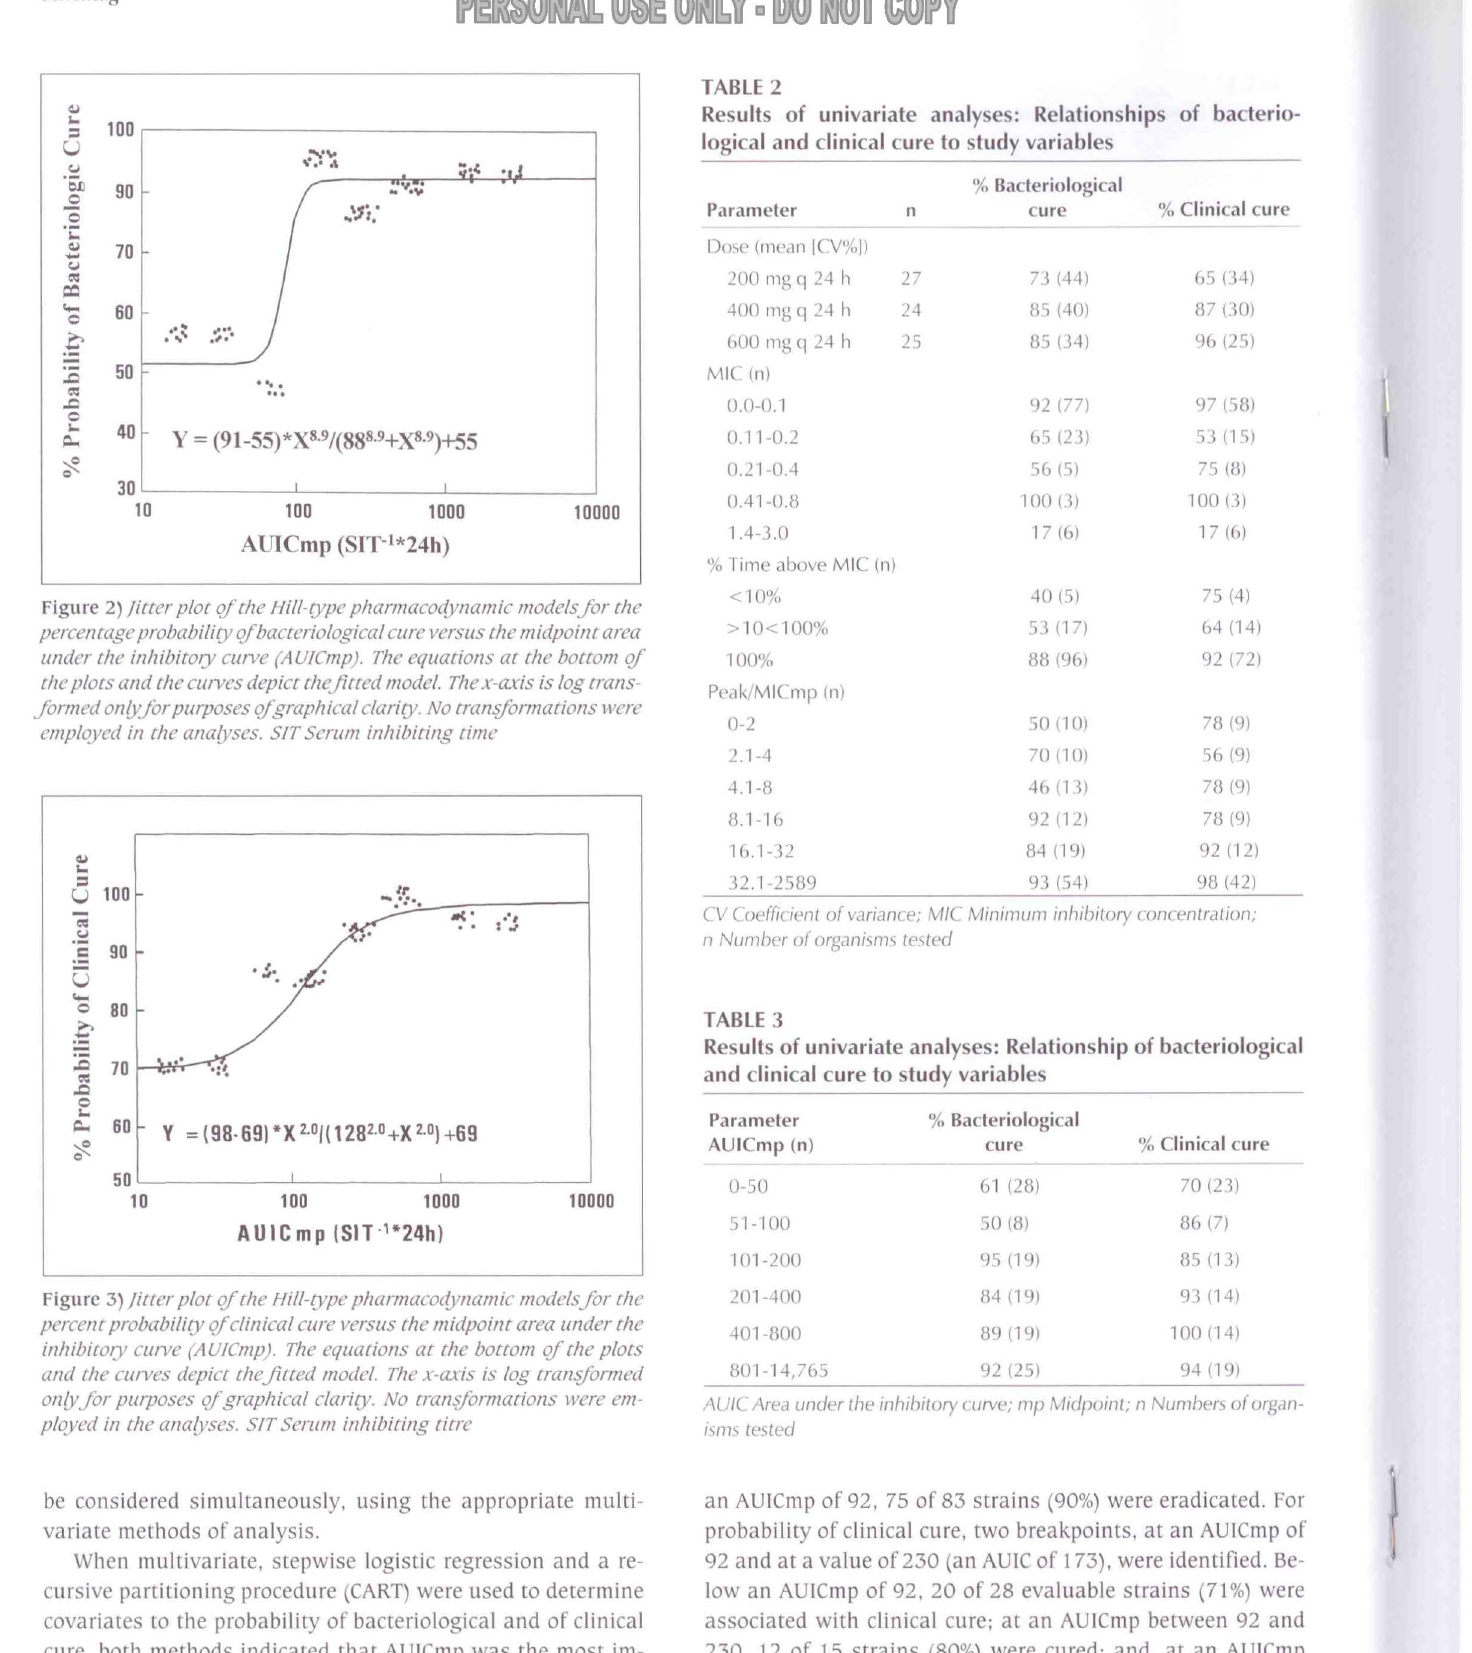
Results of univariate analyses: Relationships of bacterio